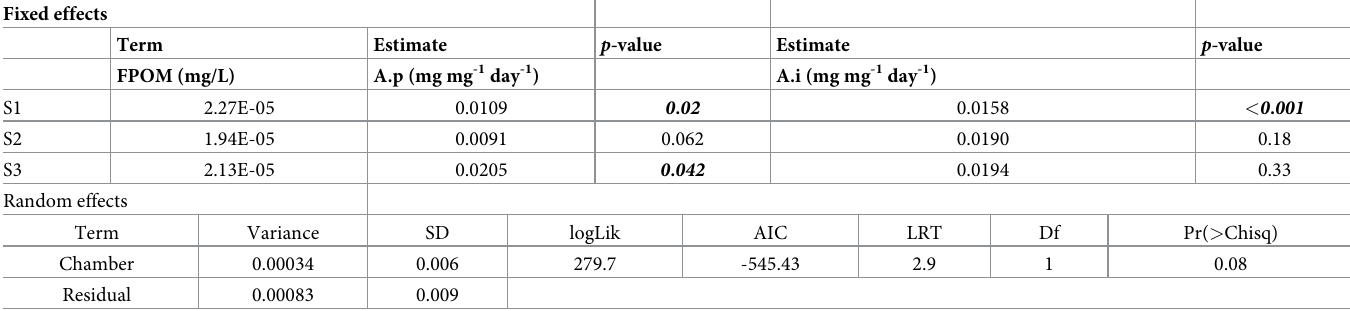
Table 6. The LMM was used to compare the growth rates of Andesiops peruvianus [A.p] and Anomalocosmoecus illiesi [A.i] with the mean FPOM during the micro- cosm experiment. Estimates were extracted from the best candidate model with fixed and random effects. Significant coefficients are in bold (CI = 95%). Temperature sce- narios S1(control), S2 (+2.5˚C), and S3 (+5˚C). LRT: likelihood ratio test statistic; and logLik: logarithmic likelihood of random effect